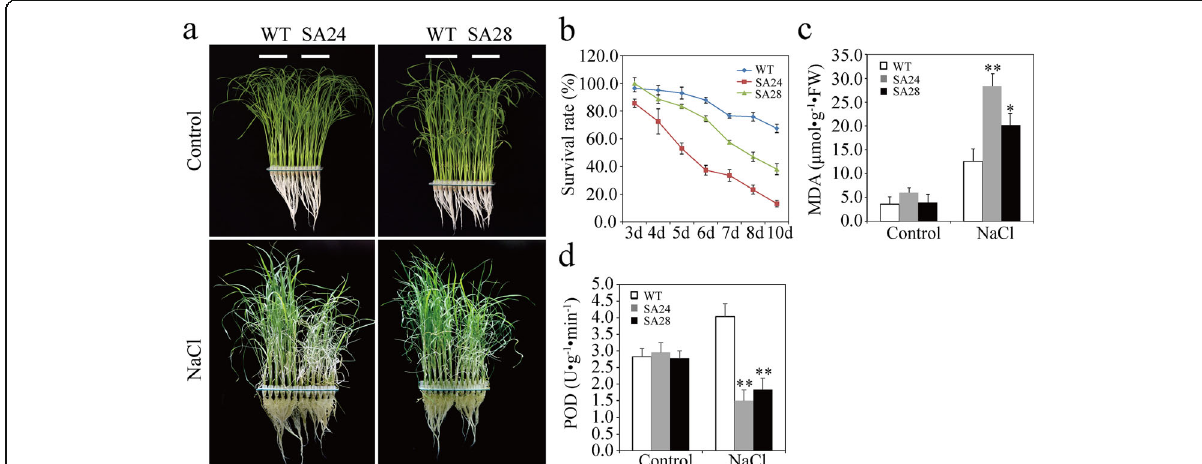
Fig. 5 Phenotypic responses of OsSGT1-overexpression ( OsSGT1-OE ) and wild-type (WT) plants under salt-stress conditions. a Phenotypes of OsSGT1-OE and WT plants treated with or without 100 mM NaCl. Photographs were taken 6 d after treatment. b Survival rates of OsSGT1-OE and WT plants under salt-stress conditions (100 mM NaCl). c Malondialdehyde (MDA) contents in OsSGT1-OE and WT plants 6 d after being treated with 100 mM NaCl. d Peroxidase (POD) activities in OsSGT1-OE and WT plants 6 d after being treated with 100 mM NaCl. Values are presented as the means and standard errors of three replicates. * P < 0.05, according to a Student ’ s t